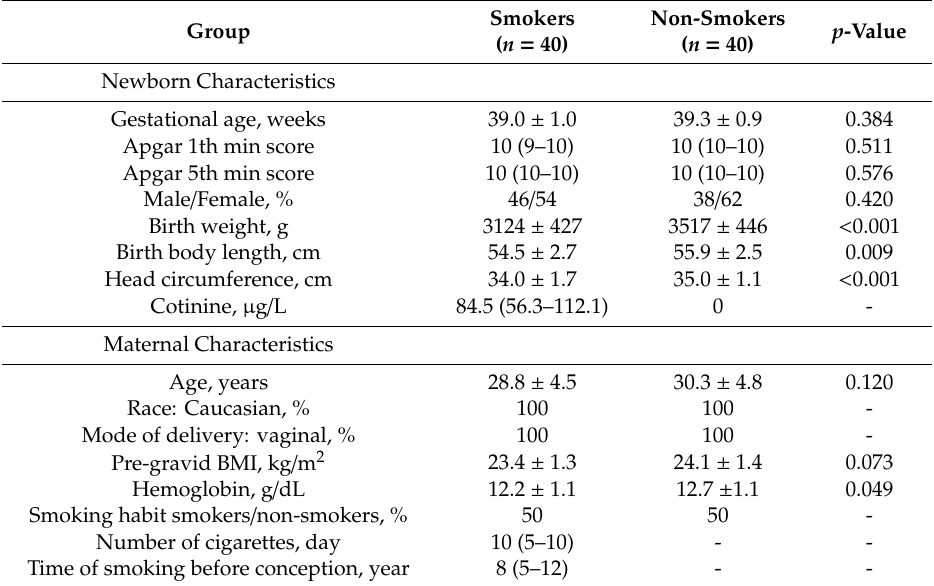
Table 1. General characteristics of the study subjects ( n = 80).